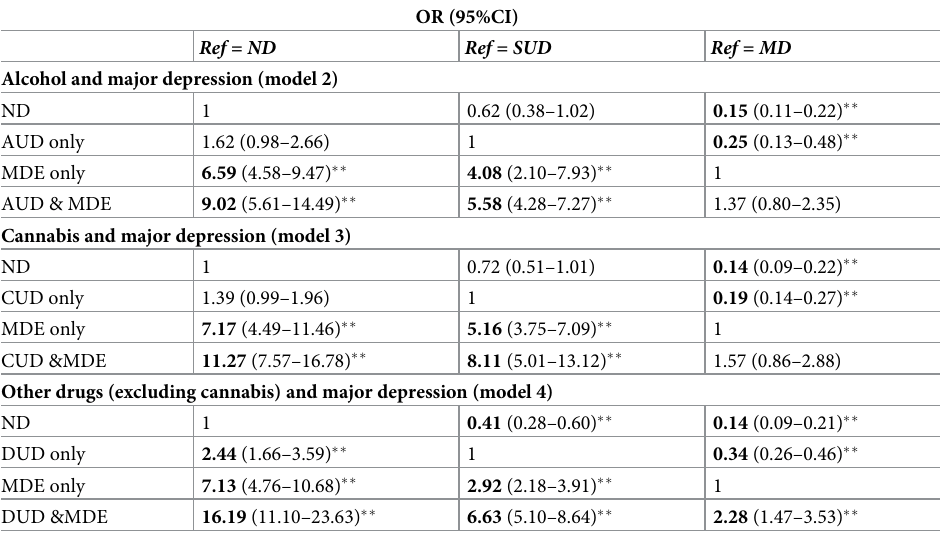
Table 3. Lifetime DSM-IV diagnoses and the risk of 12-month suicide ideation (models 2–4). OR